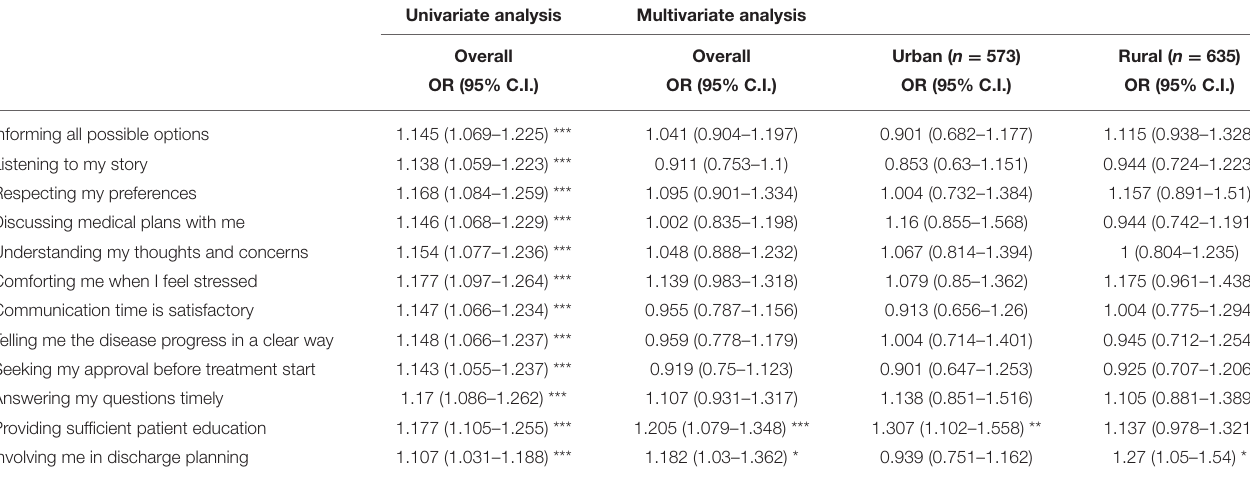
TABLE 2 | Univariate and multivariate logistic regression analyses for predictors of depressive status in 1,208 subjects after propensity score matching.